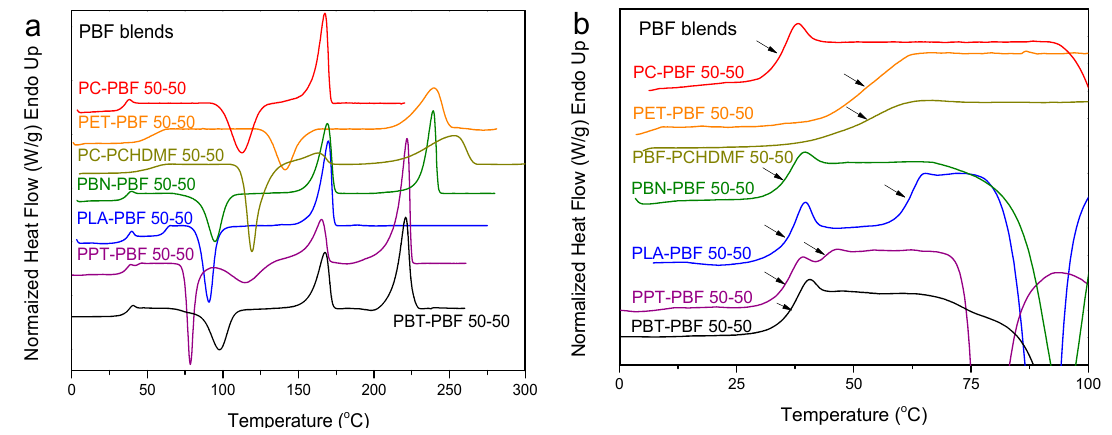
Figure 13. ( a ) DSC heating thermograms, ( b ) details of DSC thermograms in the T g region for melt- quenched PBF blend samples with various polymers and 50-50 composition.